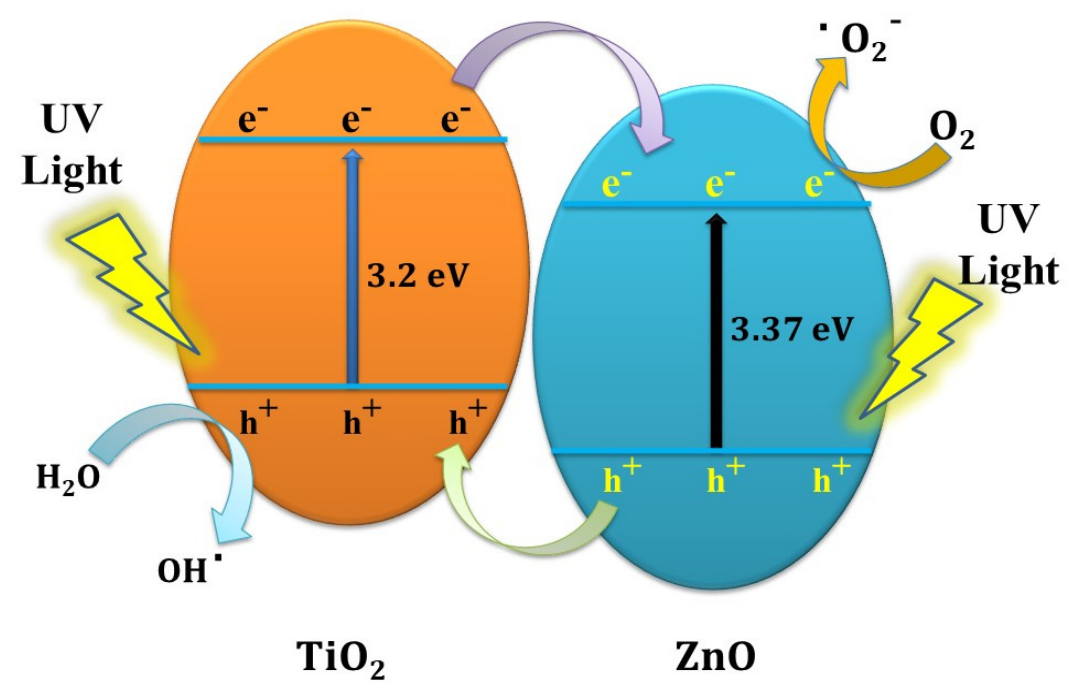
Figure 7. Reusability of TZU75 for MO degradation under UV light